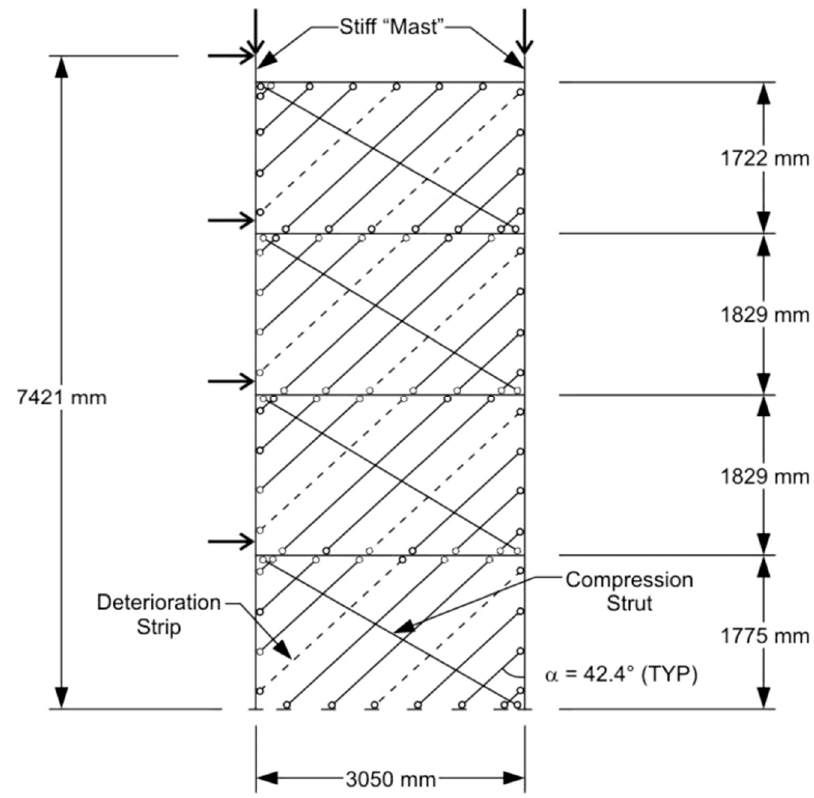
Figure 2. The modified strip model by Shishkin et al. [26].